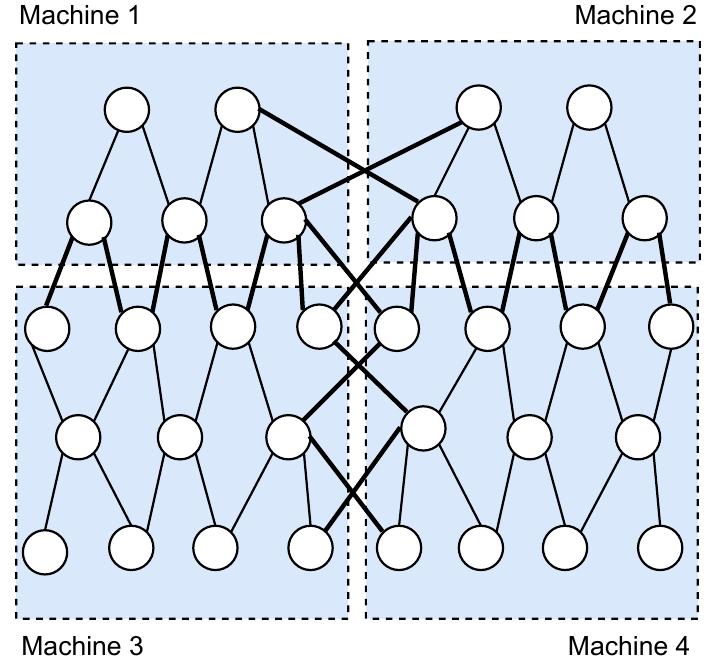
Figure 1. An example of model